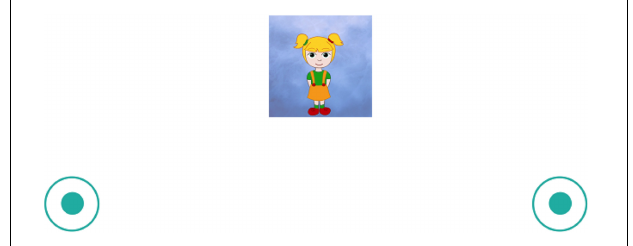
FIGURE 1 | Visual configuration appearing in the music perception tasks (shapes and colors differ among